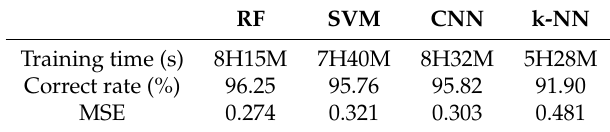
Table 1. Results of classification algorithms: RF, SVM, CNN, k-NN of BD-HLG database.